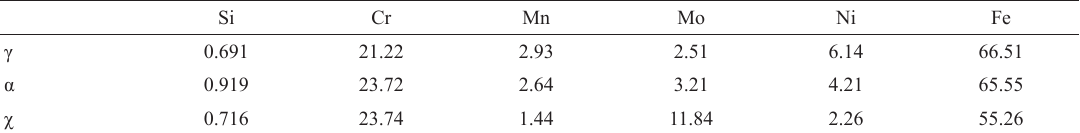
Table 4: Contents of principal metallic elements in γ, α and χ-phases as determined by EDS after FHPP in DSS (wt.%).